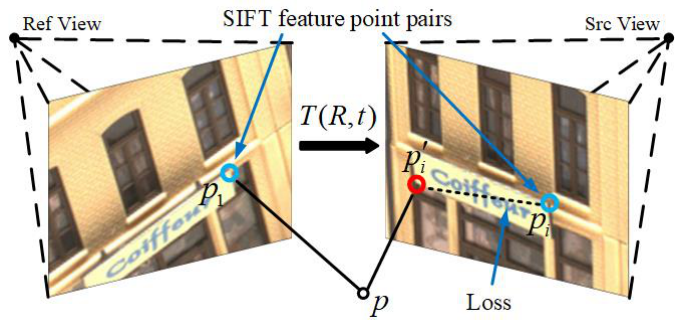
Figure 5. Principle of feature point consistency loss.